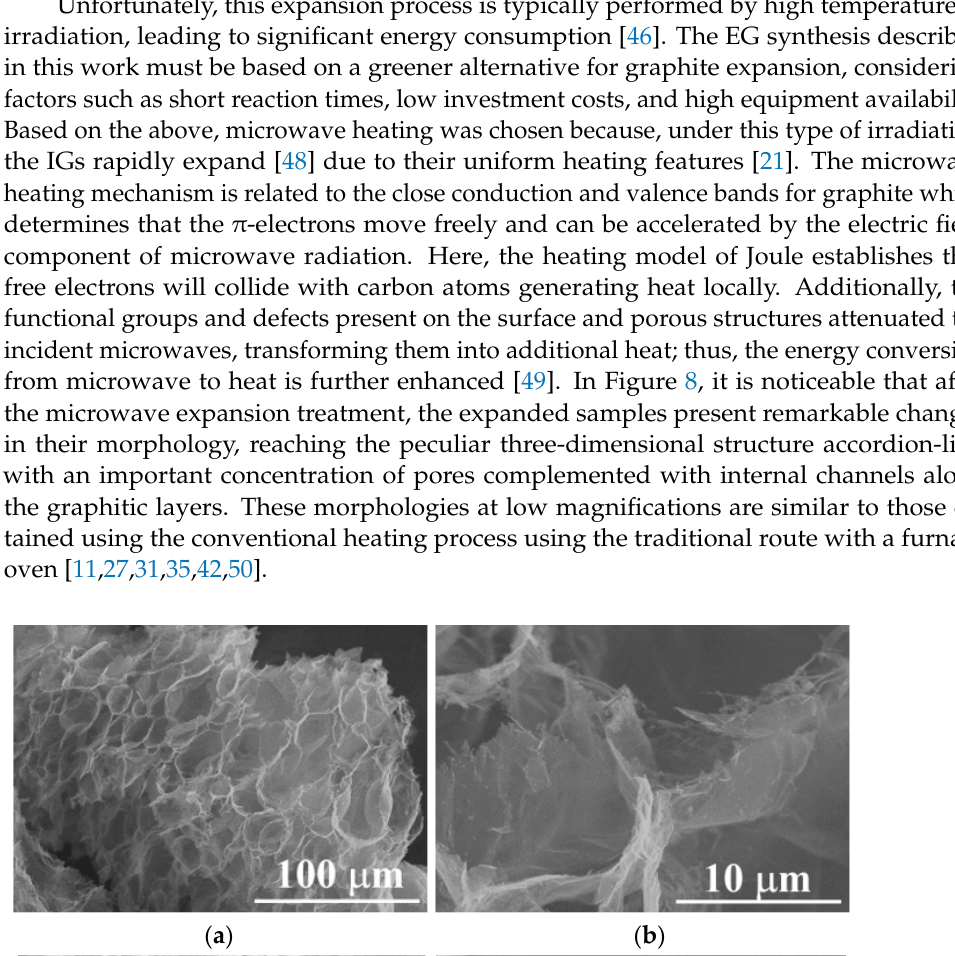
0-2 and ( c , d ) EG 5-2